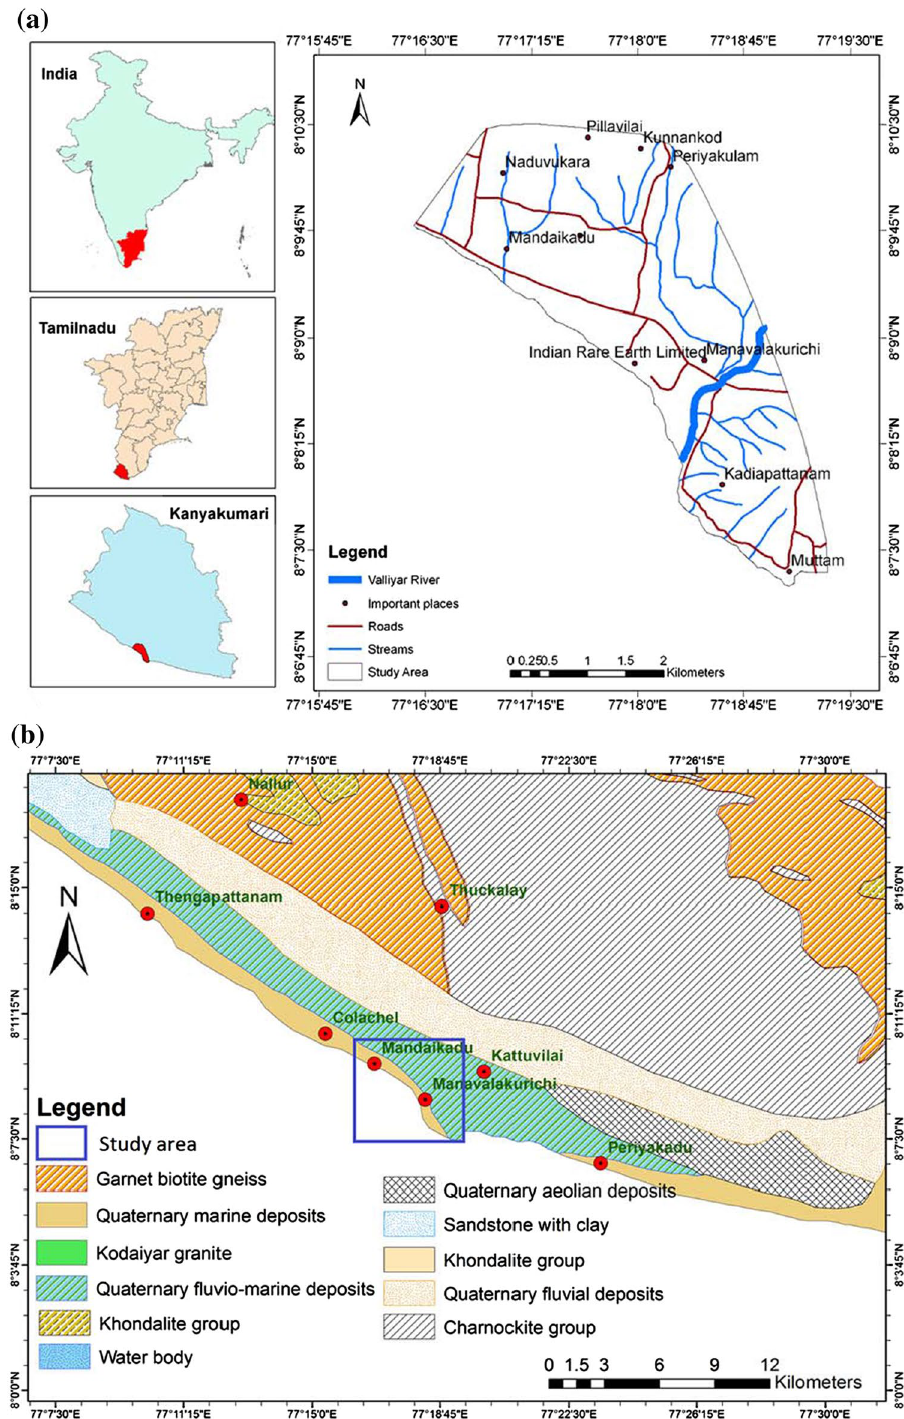
Fig. 1 a Study area and sample locations b Geology map of the study area (Maps digitized from Survey of India toposheet No. 58